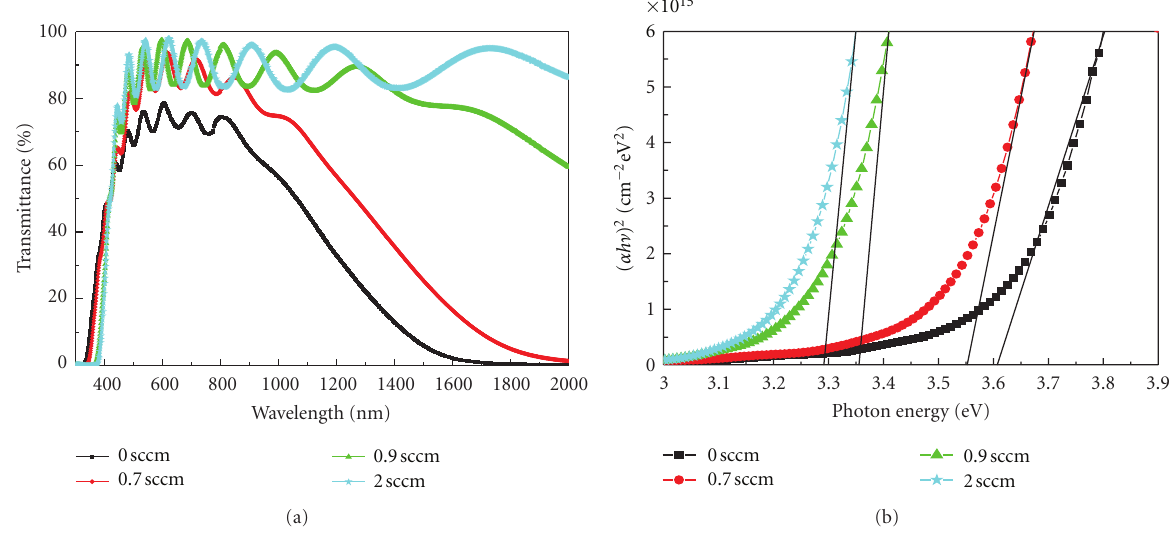
Figure 1: (a) Transmittance spectra of AZO thin films with various optical band gaps. (b) Evaluation of the AZO thin films’ ( αhv ) 2 versus h ν